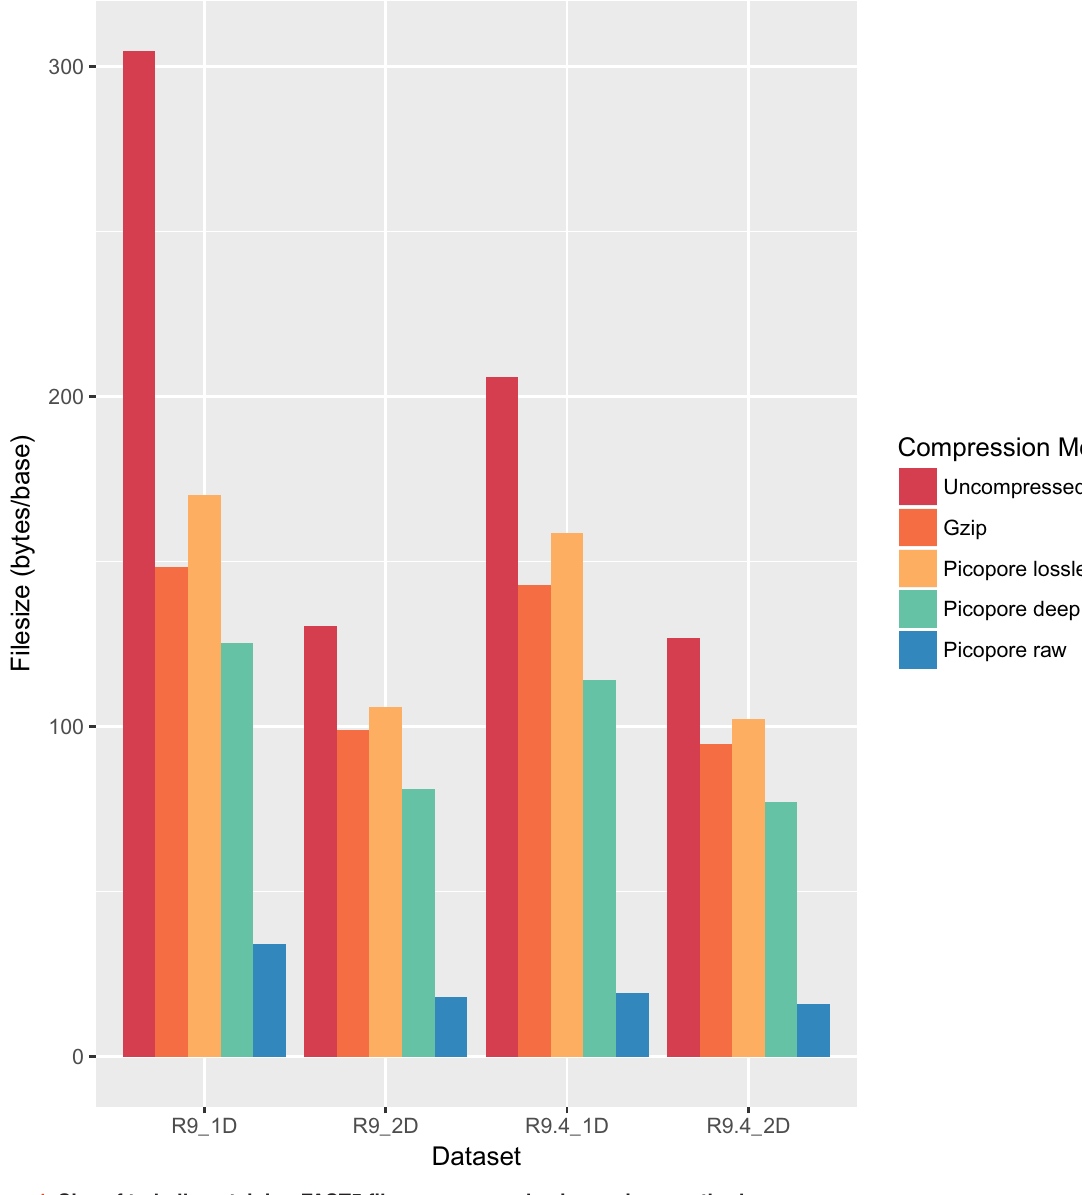
Figure 1. Size of tarball containing FAST5 files compressed using various methods.